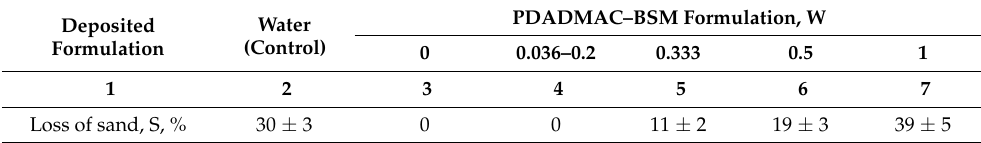
Table 2. Loss of sand from the polymer-sand crusts prepared with PDADMAC–BSM formulations. Deposited